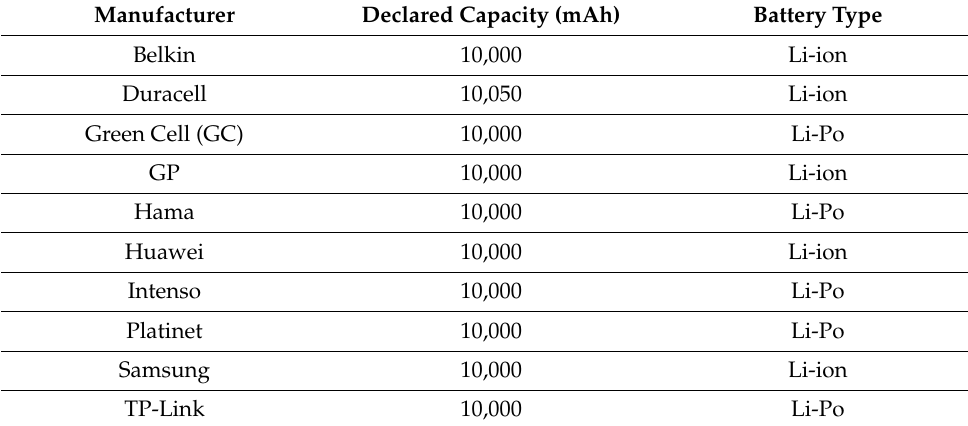
Table 2. Power bank devices for the study.